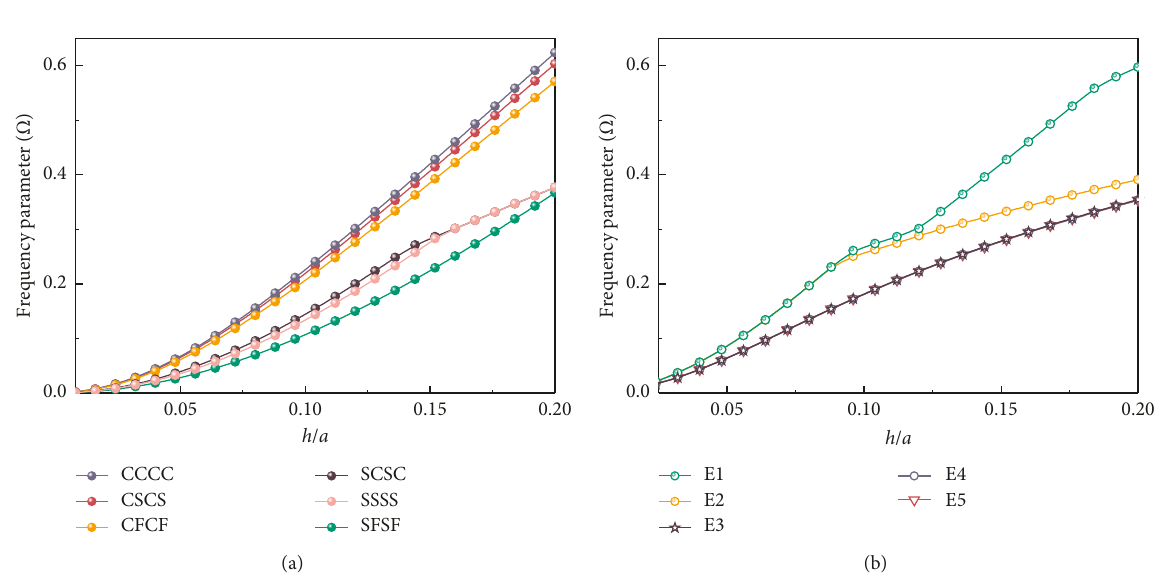
Figure 4: Nondimensional frequency parameter of type I porous rectangular plates with different boundary conditions: (a) classical boundary conditions; (b) elastic boundary